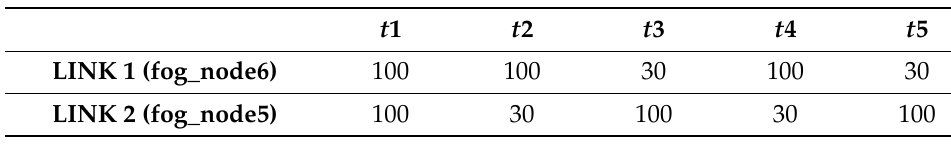
Table 2. Throughput on link1 and link2 (Mbps).